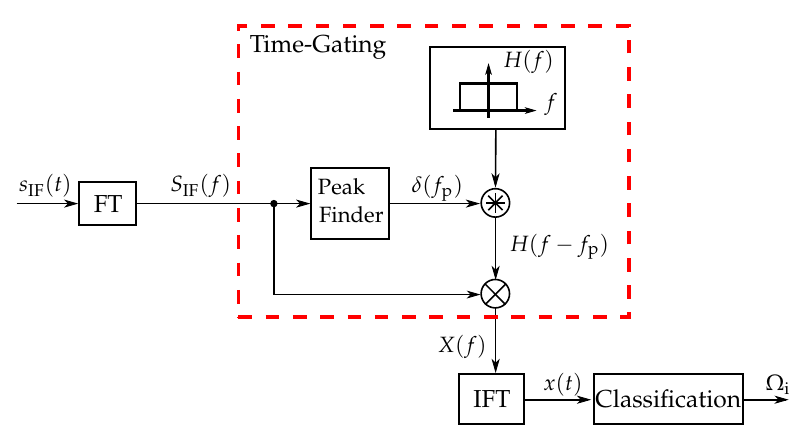
Figure 3. Signal flow diagram of the feature extraction and classification [20].